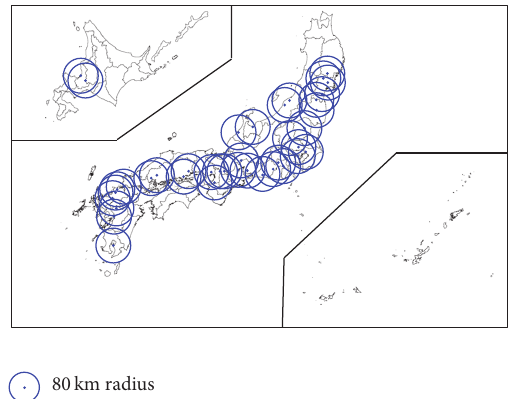
Figure 4: Distribution of all radars in XRAIN and their detection areas. The maximum detecting radius of each radar is